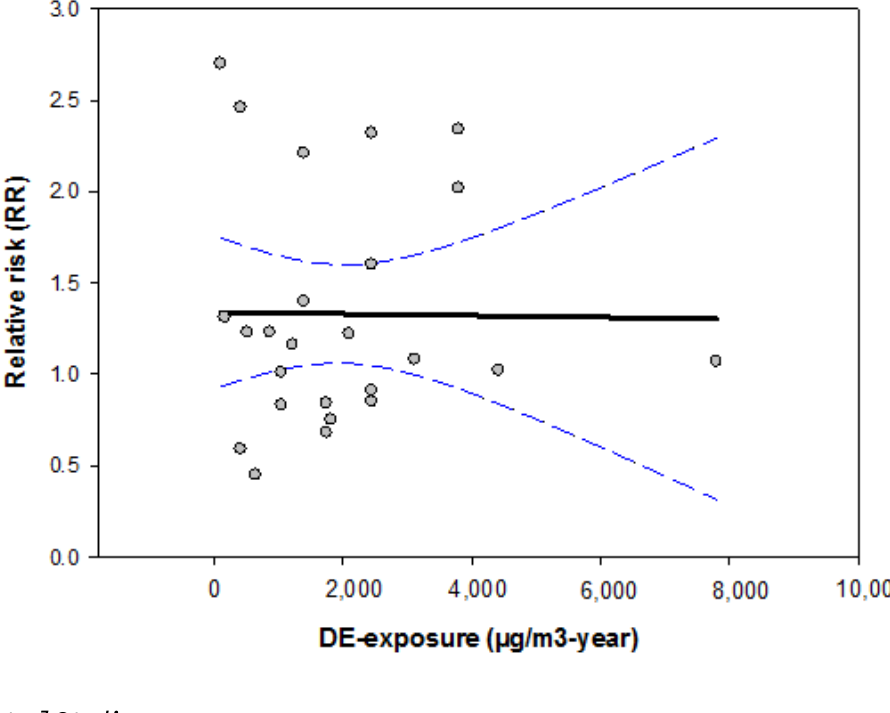
Figure 1. Effects of DE-exposures on the risk of lung cancer given in previously published cohort